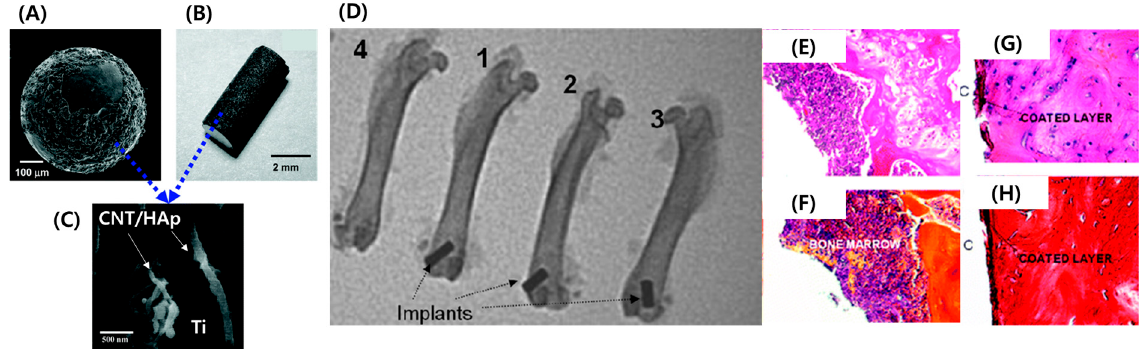
Figure 2. HAp/CNT-coated implant showing ( A ) a spherical Ti bead, ( B ) a Ti road, and ( C ) the top surface of the plasma-sprayed HAp-CNT coating with embedded CNTs in HAp. ( D ) X-ray images of rat femoral bones after one-month implantation showing (1) an uncoated Ti implant, (2) an HAp-coated Ti implant, (3) an HA-CNT-coated implant, and (4) no implant. ( E – H ) Histological results (40 × ) for mice bones that were implanted with an HA-CNT-coated implant fabricated as ( E , F ) spherical beads and ( G , H ) a rod-shaped implant. ( E , G ) Mallory coloration images and ( F , H ) hematoxylin and eosin coloration images. Copyright © 2011 American Chemical Society, Reference [21].